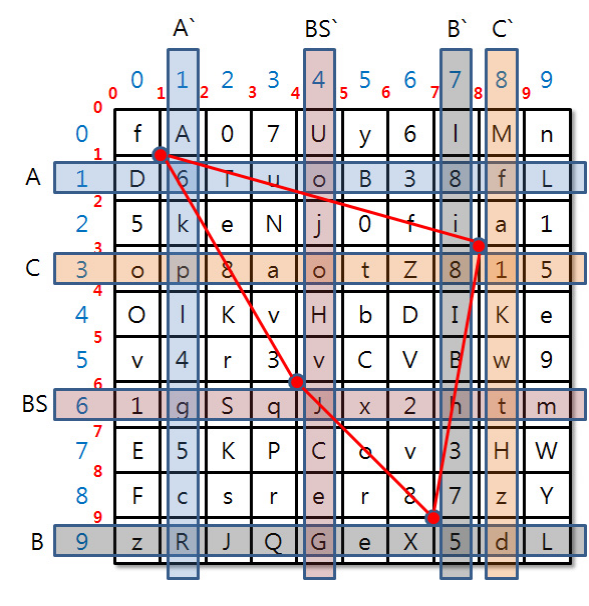
Figure 5. Keyset work for the group key extraction.